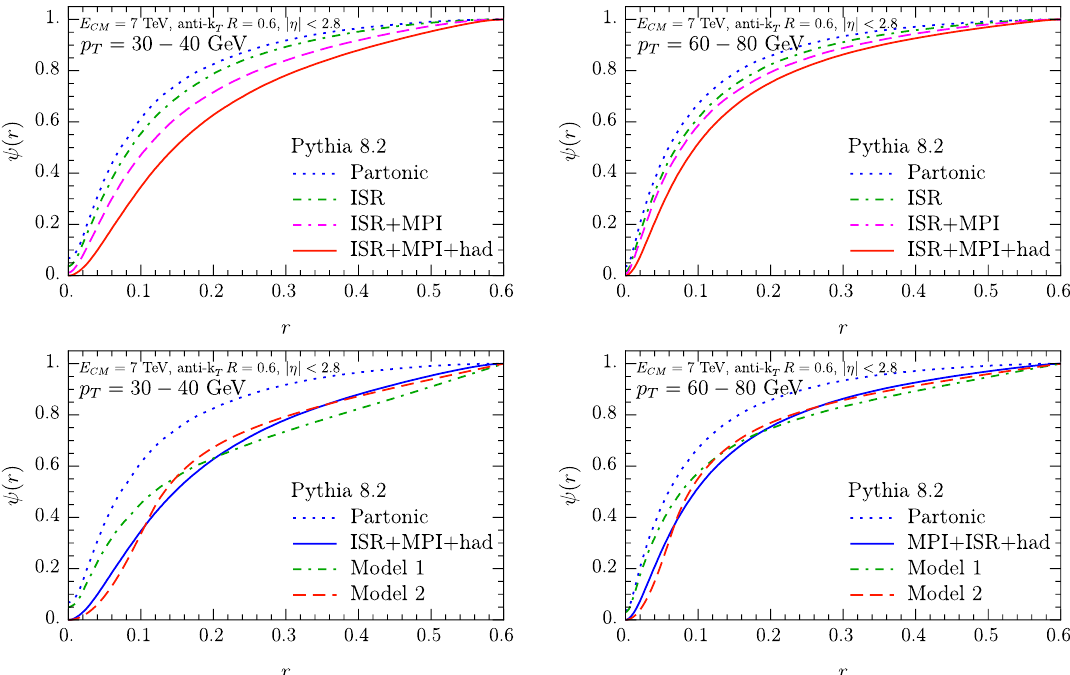
Figure 10 . Jet shape in Pythia at E cm = 7 TeV for anti- k T jets with radius R = 0 : 6, rapidity (cid:17) < 2 : 8 and transverse momentum p T = 30{40 GeV (left) and p T = 60{80 GeV (right). The top j j row shows results at parton level (blue dotted), including initial-state radiation (green dot-dashed), also multi-parton interactions (magenta dashed), and also hadronization (blue solid). The bottom row repeats the blue dotted and solid curves, where the e(cid:11)ect of ISR, MPI and hadronization are either modeled using eq. (5.1) (green dot-dashed) or eq. (5.2) (orange dashed), and the parameter f is